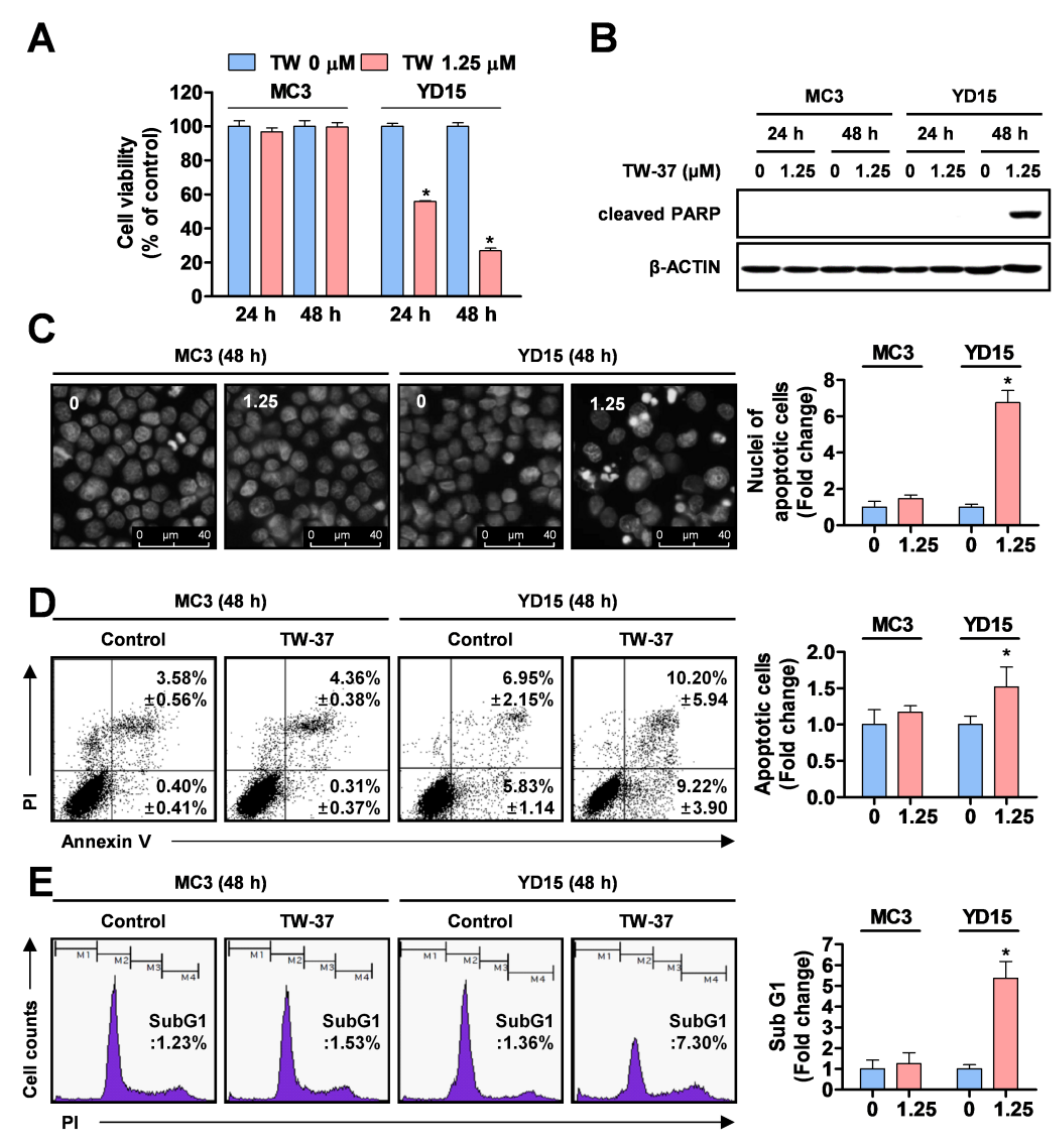
Figure 1. Effects of TW-37 on cell viability and apoptosis of human mucoepidermoid carcinoma (MEC) cell lines. MC3 and YD-15 cells were treated with dimethyl sulfoxide (DMSO) or a 1.25 μM concentration of TW-37 for 24 h or 48 h. ( A ) Cell viability was examined by a trypan blue exclusion assay. The results represent the mean ± SD of triplicate from three independent experiments and significant differences are shown (*, p <0.05). ( B ) Cleavage of poly (ADP-ribose) polymerase (PARP) was analyzed by western blotting and actin was used as a loading control. ( C ) Nuclear fragmentation and DNA condensation were visualized by fluorescence microscopy. Representative images from three independent experiments are shown (magnification, X400). ( D ) Fluorescence-activated cell sorting (FACS) analysis of annexin V / propidium iodide (PI) staining. The annexin V-positive cells are expressed as the percentage of apoptotic cells. ( E ) FACS analysis of PI staining. The histogram represents the distribution of cell cycles and the graphs represent the mean ± SD from three independent experiments. *, p < 0.05.